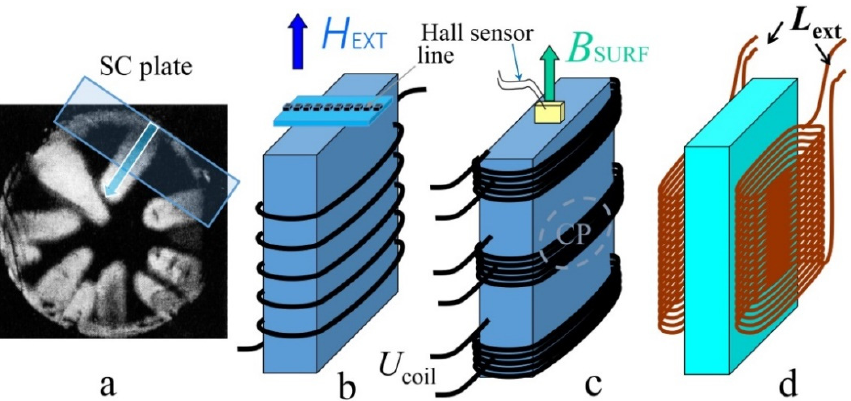
Figure 1. ( a ) Flux jump frozen in the form of “fingers”; Nb disc, T = 1.7 K (Figure 1a from Ref. [13]). The arrangement of pickup coils on superconducting plate for the avalanche flux registration: ( b ) in the whole plate’s volume, ( c ) on three height levels, and ( d ) in magnetic stray field ( L ext ). Hall sensor line and probe for magnetic induction ( B surf ) measurement are presented in ( b , c ); U coil ( t )—voltage on the pickup coil; CP is the central part, where the avalanches are mainly triggered.